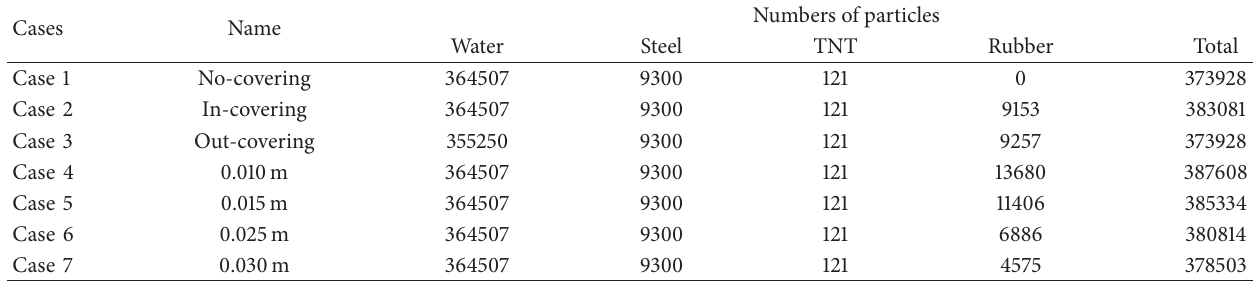
Table 8: Different cases of single cylindrical shell and numbers of particles (different positions are listed as Cases 1–3, in the case where the rubber thickness is 0.020 m; different thicknesses are listed as Cases 4–7, in the case where the inner surface is coated with rubber).